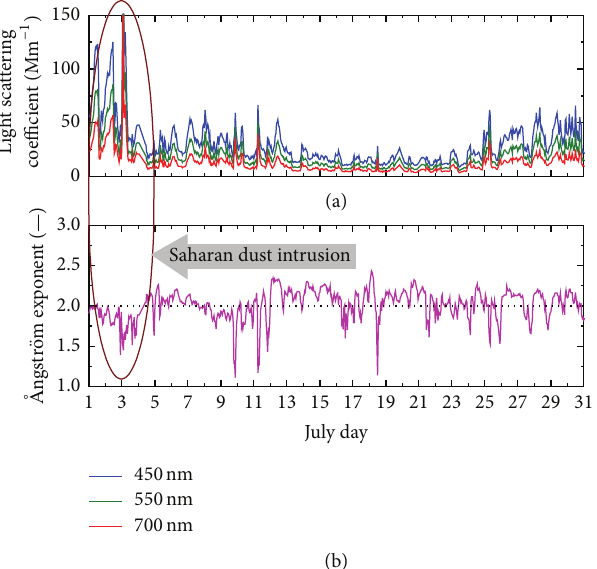
Figure 1: (a) The light scattering coefficient for the wavelength of 450, 550, and 700 nm during July 2012. (b) The calculated ˚Angstr¨om exponent for 450 and 700 nm wavelength pair filtered with a 2-point moving average filter. The oval highlighted area shows Saharan dust